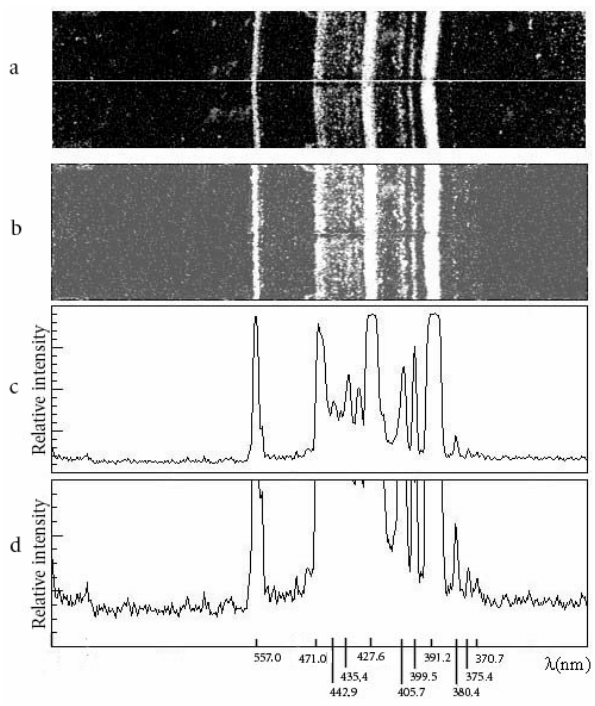
Fig. 14. Auroral spectrum obtained by Sykora with 28 hours expo- sure and recovered by modern Figure 14. Auroral spectrum obtained by Sykora with 28 hours exposure and recovered by modern methods